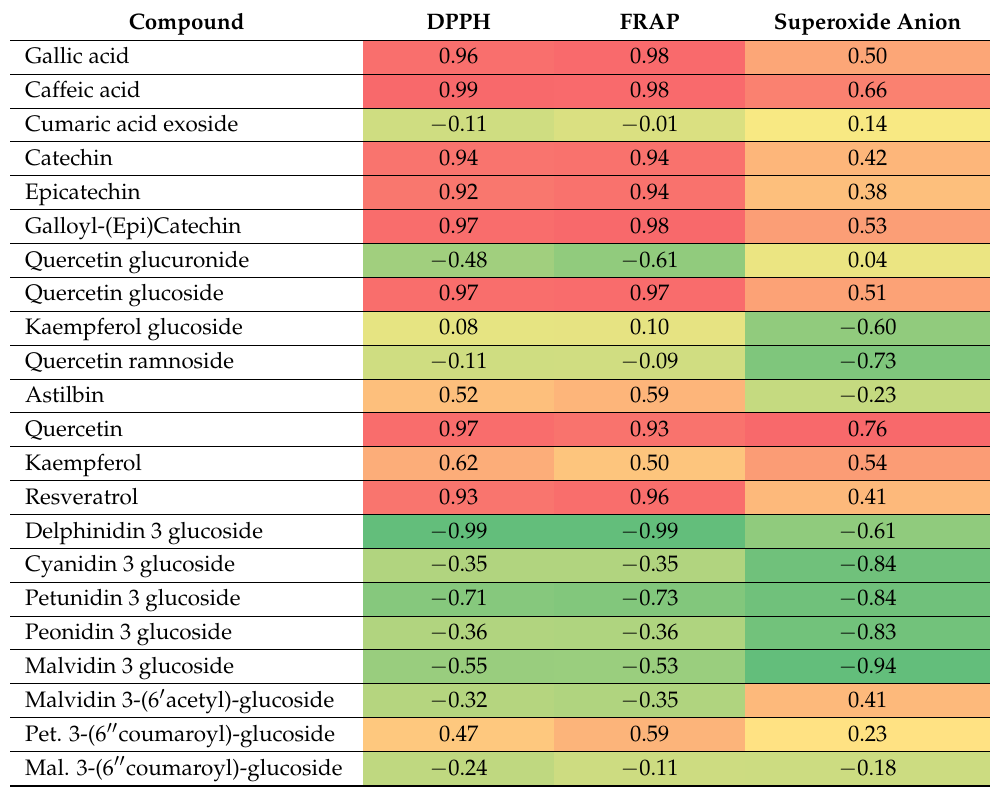
Table 7. Pearson correlation analysis between the polyphenolic compounds and the antioxidant activities among the four grape cultivars. The values marked in red show the highest correlation, those in green the lowest. Color legend: for values from 1.0 to 0.75 = red, from 0.75 to 0.50 = dark orange; from 0.50 to 0.25 = orange; from 0.25 to 0.0 = yellow; from 0.0 to − 0.25 = yellowish;